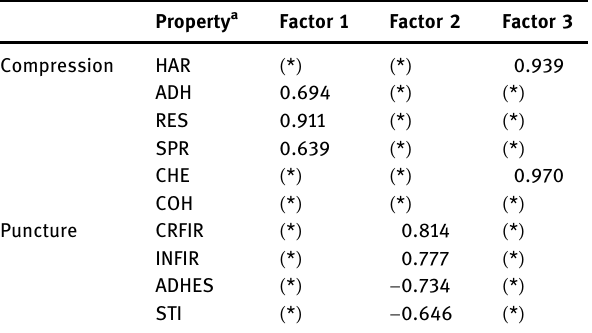
Table 2: Component matrix obtained by FA with Varimax